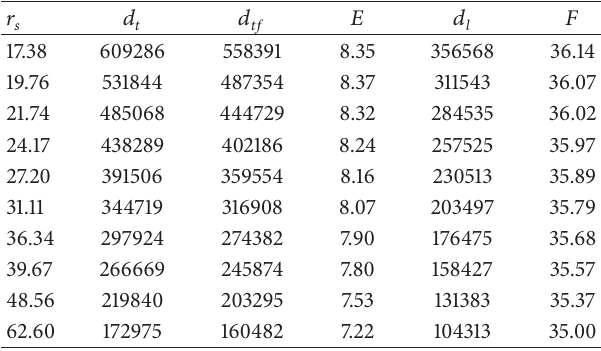
Table 4: Comparison of distance traveled by the MSNs in triangle based traversal, fault tolerant traversal, and line based traversal.